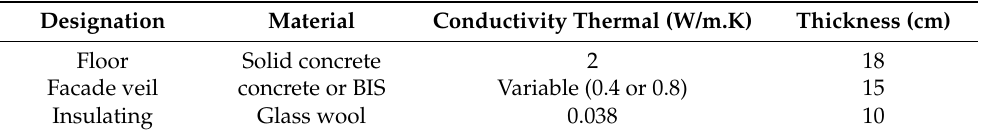
Table 4. Properties of the materials used for the model adopted from the facade/intermediate floor connection.